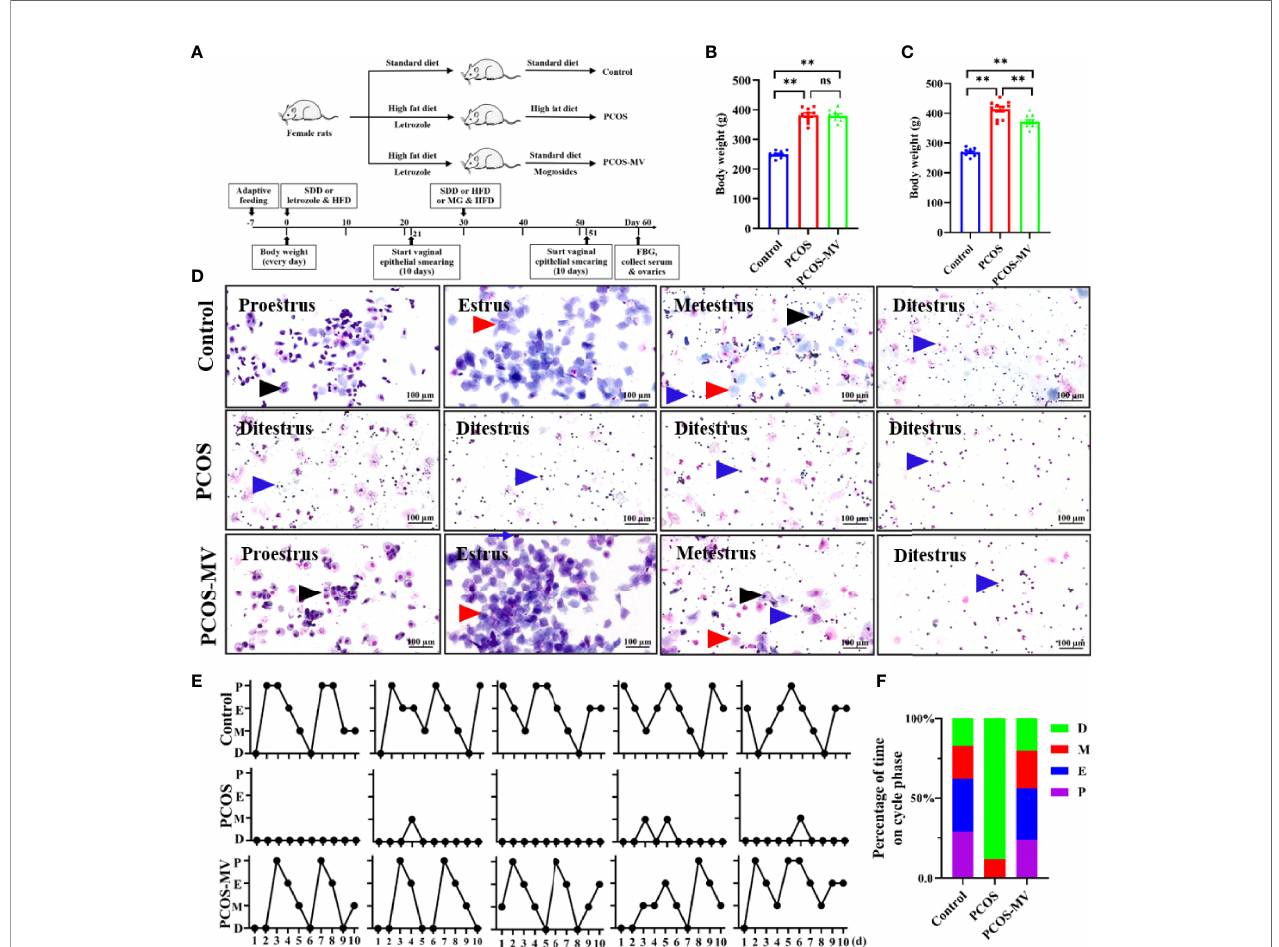
FIGURE 1 | Effects of MV administration on body weight and vaginal cytology of PCOS rats. (A) Schematic diagram showing the experimental treatment of PCOS and PCOS-MV rats. (B) Body weight of rats after modeling (n = 10, day 30). (C) Body weight of rats after MV treatment (n = 10, day 60). (D) Cytological assessment of vaginal smears (n = 10, day 51-60). (E) Representative estrous cycles. (F) Quantitative analysis about the percentage of time on different phase of estrous cycles (n = 10 per group). Signi fi cant differences between groups were indicated as ** P < 0.01. not signi fi cant difference ( P > 0.05). MV, mogroside